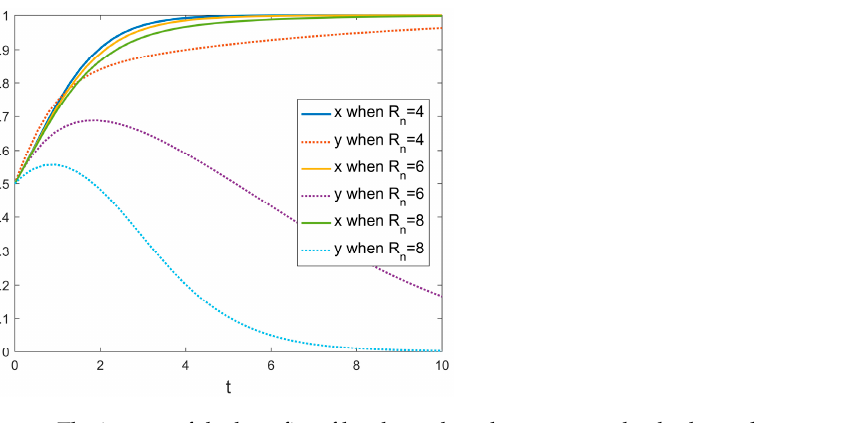
Figure 7. The impact of local government’s incentives ( a ) and penalties ( b ) on the evolutionary game. 6. Discussion This paper presents a model construction and analysis based on the reality of grassland degradation, which can be further discussed in the context of the reality of grassland degradation in the Qinghai-Tibet Plateau of China. Grassland degradation on